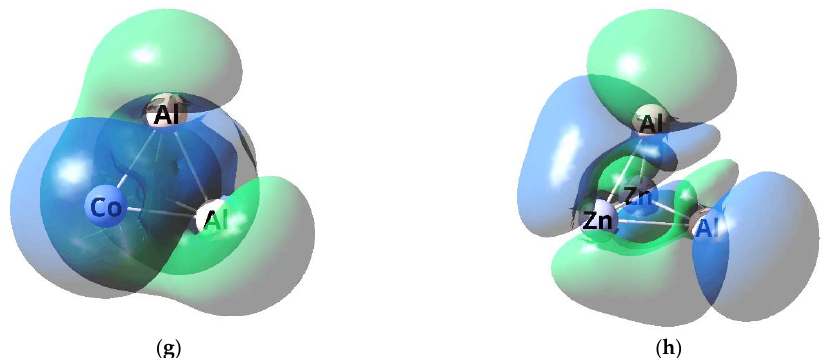
Figure 4. The pattern of distribution of the spin density in the Al 2 Sc 2 (3-I) ( a ), Al 2 Ti 2 (3-I) ( b ), Al 2 V 2 (3-I) ( c ), Al 2 Cr 2 (1-I)* ( d ), Al 2 Mn 2 (1-I)* ( e ), Al 2 Fe 2 (5-I) ( f ), Al 2 Co 2 (5-I) ( g ), and Al 2 Zn 2 (1-I)* ( h ) metal clusters. For Al 2 Ni 2 (1-I) and Al 2 Cu 2 (1-I), these pictures are absent since, for them, <S**2> = 0.